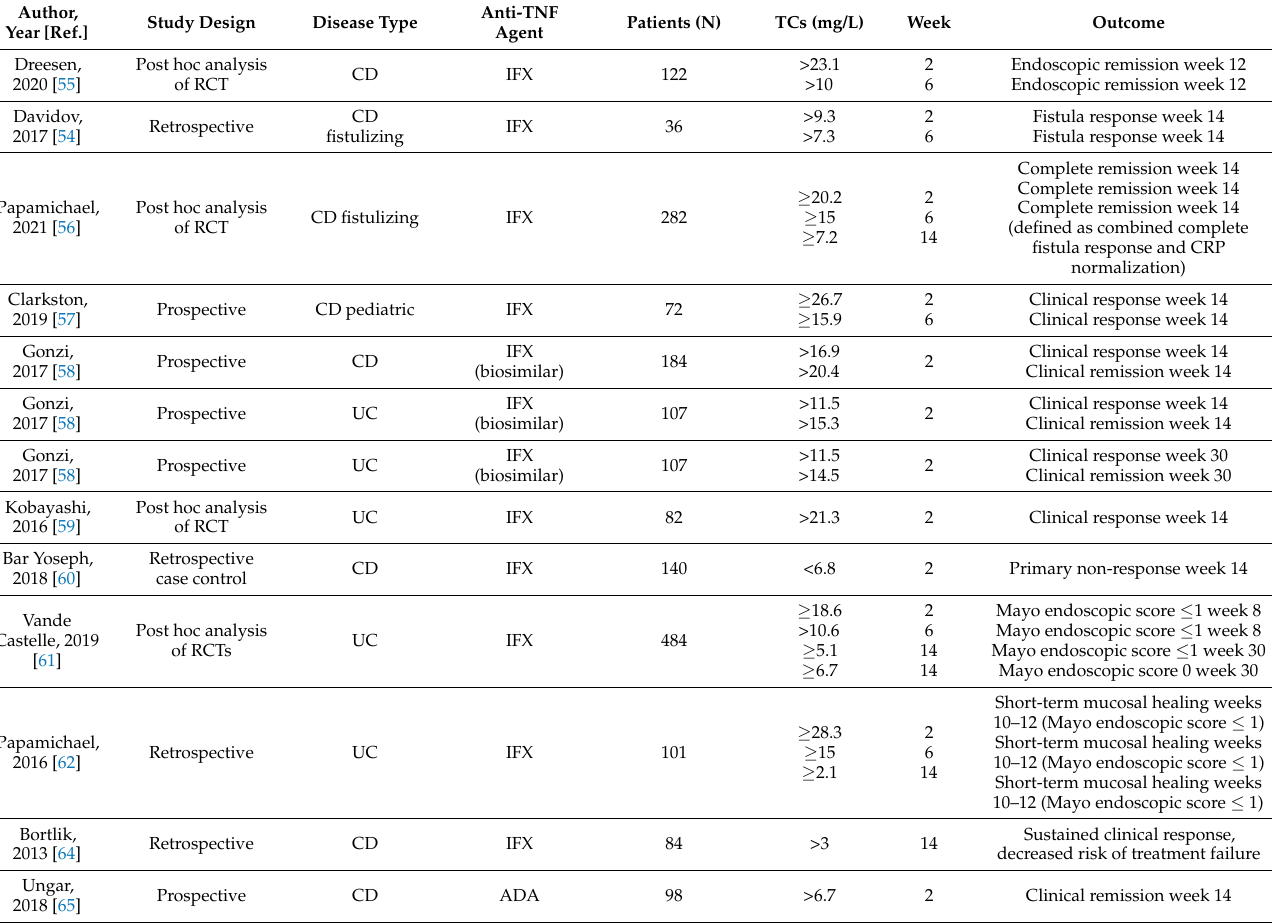
Table 3. TDM thresholds during induction treatment and associated short- and long-term therapeutic outcomes for anti-TNF